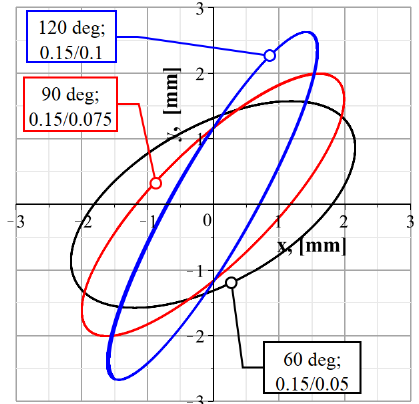
Figure 9. Trajectories of the working member’s mass center motion at different values of the phase shift angle 𝜑 and static moments of the unbalanced rotors 𝑚 1 𝑟 1 /𝑚 2 𝑟 2 under their counter-rotation shift angle ϕ and static moments of the unbalanced rotors m 1 r 1 / m 2 r 2 under their conditions, as follows: 𝜔 2 = −𝜔 1 .